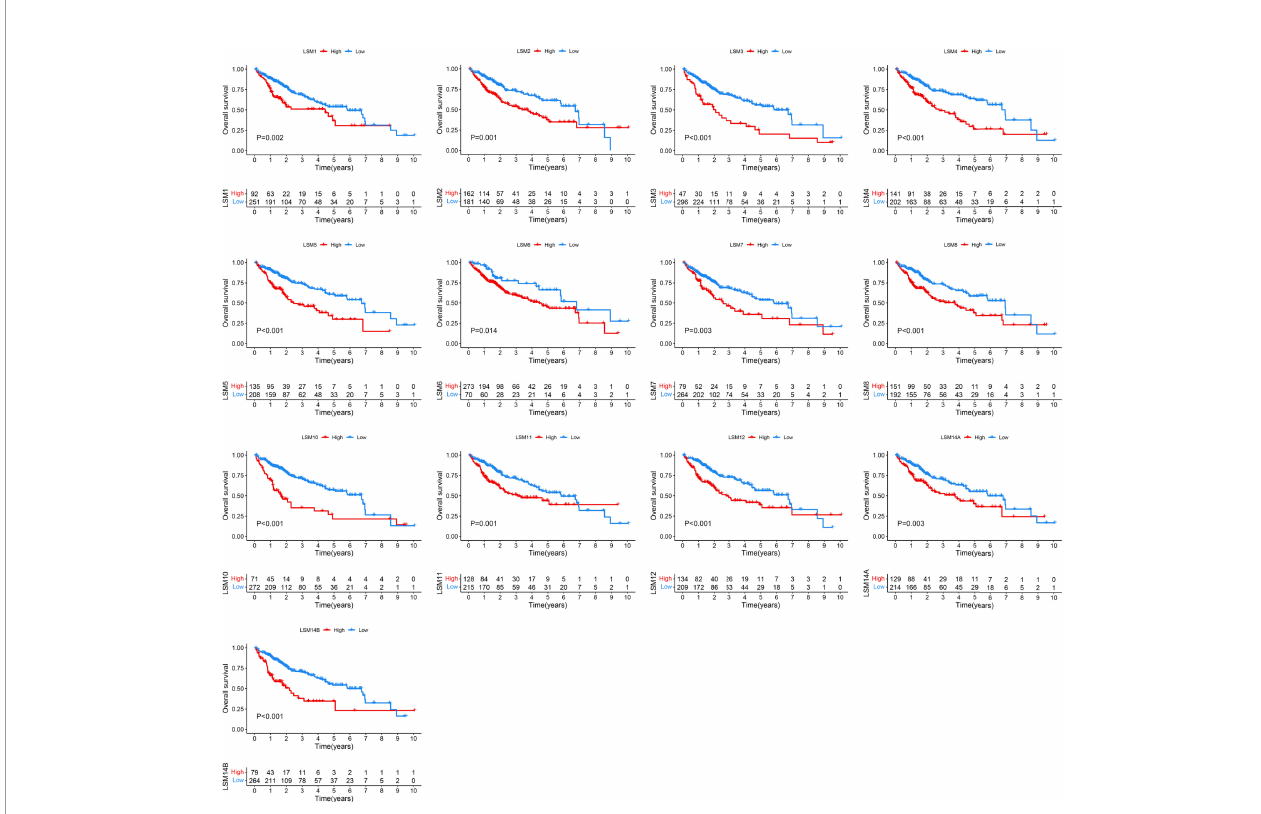
FIGURE 3 | KM survival curves for OS of LSM family members in HCC. KM, Kaplan – Meier; OS, overall survival; LSM, Smith-like (LSM) family